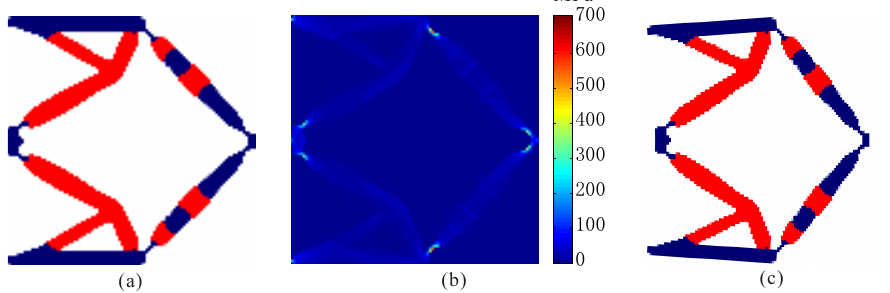
Figure 2. The results for topological design of multi-material compliant inverter without stress constraints. ( a ) Optimal topology; ( b ) stress distribution; ( c ) deformed configuration.